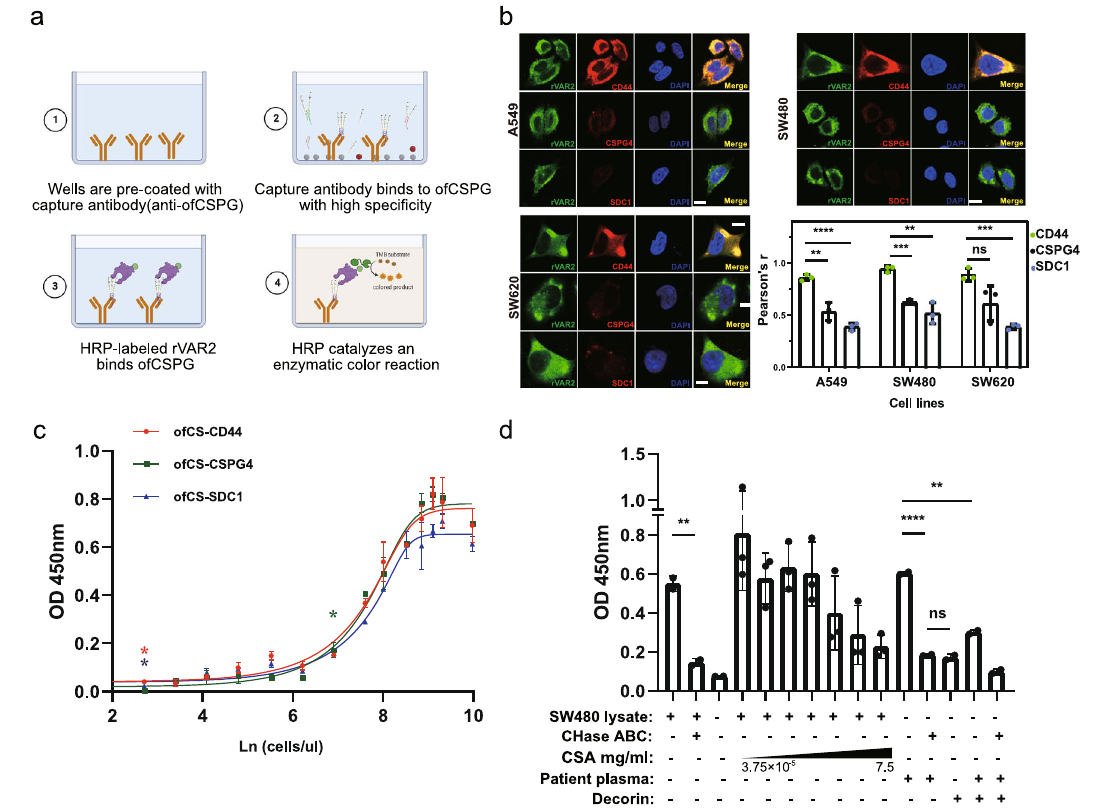
Fig. 2 | Schematic of sandwich ELISA, the sensitivity and speci fi city to detect ofCSPGs. a Schematic of sandwich ELISA work fl ow. The fi gure was created with Biorender.com. b Colocalization of ofCS with core proteins detected by rVAR2-3 and anti-CD44, CSPG4, and SDC1 antibodies ( n =3, biologically independent experiments). P =0.0039and P <0.0001 forCD44vs.CSPG4and CD44vs.SDC1in A549, P =0.0001 and P =0.0025for CD44vs.CSPG4and CD44vs.SDC1inSW480, P =0.0549 and P =0.0002 for CD44 vs. CSPG4 and CD44 vs. SDC1 in SW620. R =1 represents perfect correlation. Scale bar = 10 μ m. c The sensitivity of ELISA for ofCS-CD44, -CSPG4, and -SDC1 biomarkers. The cancer cell line (SW480) spiked